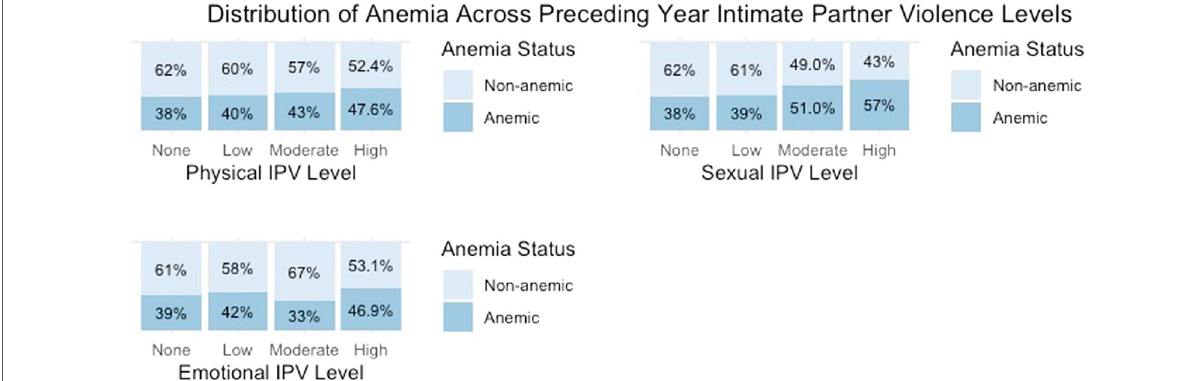
Fig. 3 Distribution of anemic status across preceding year IPV intensity levels